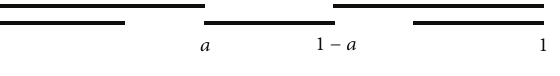
Figure 8: Interval placement, 𝑎 = (3 − √5)/2 , 𝑛 = 2 .